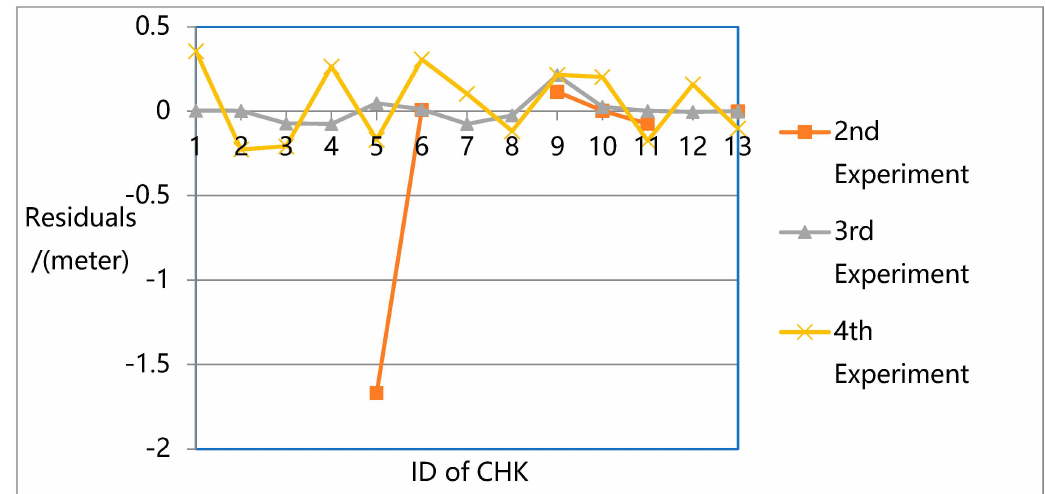
Figure 16. Residuals Plot of CHKs in Z-direction in